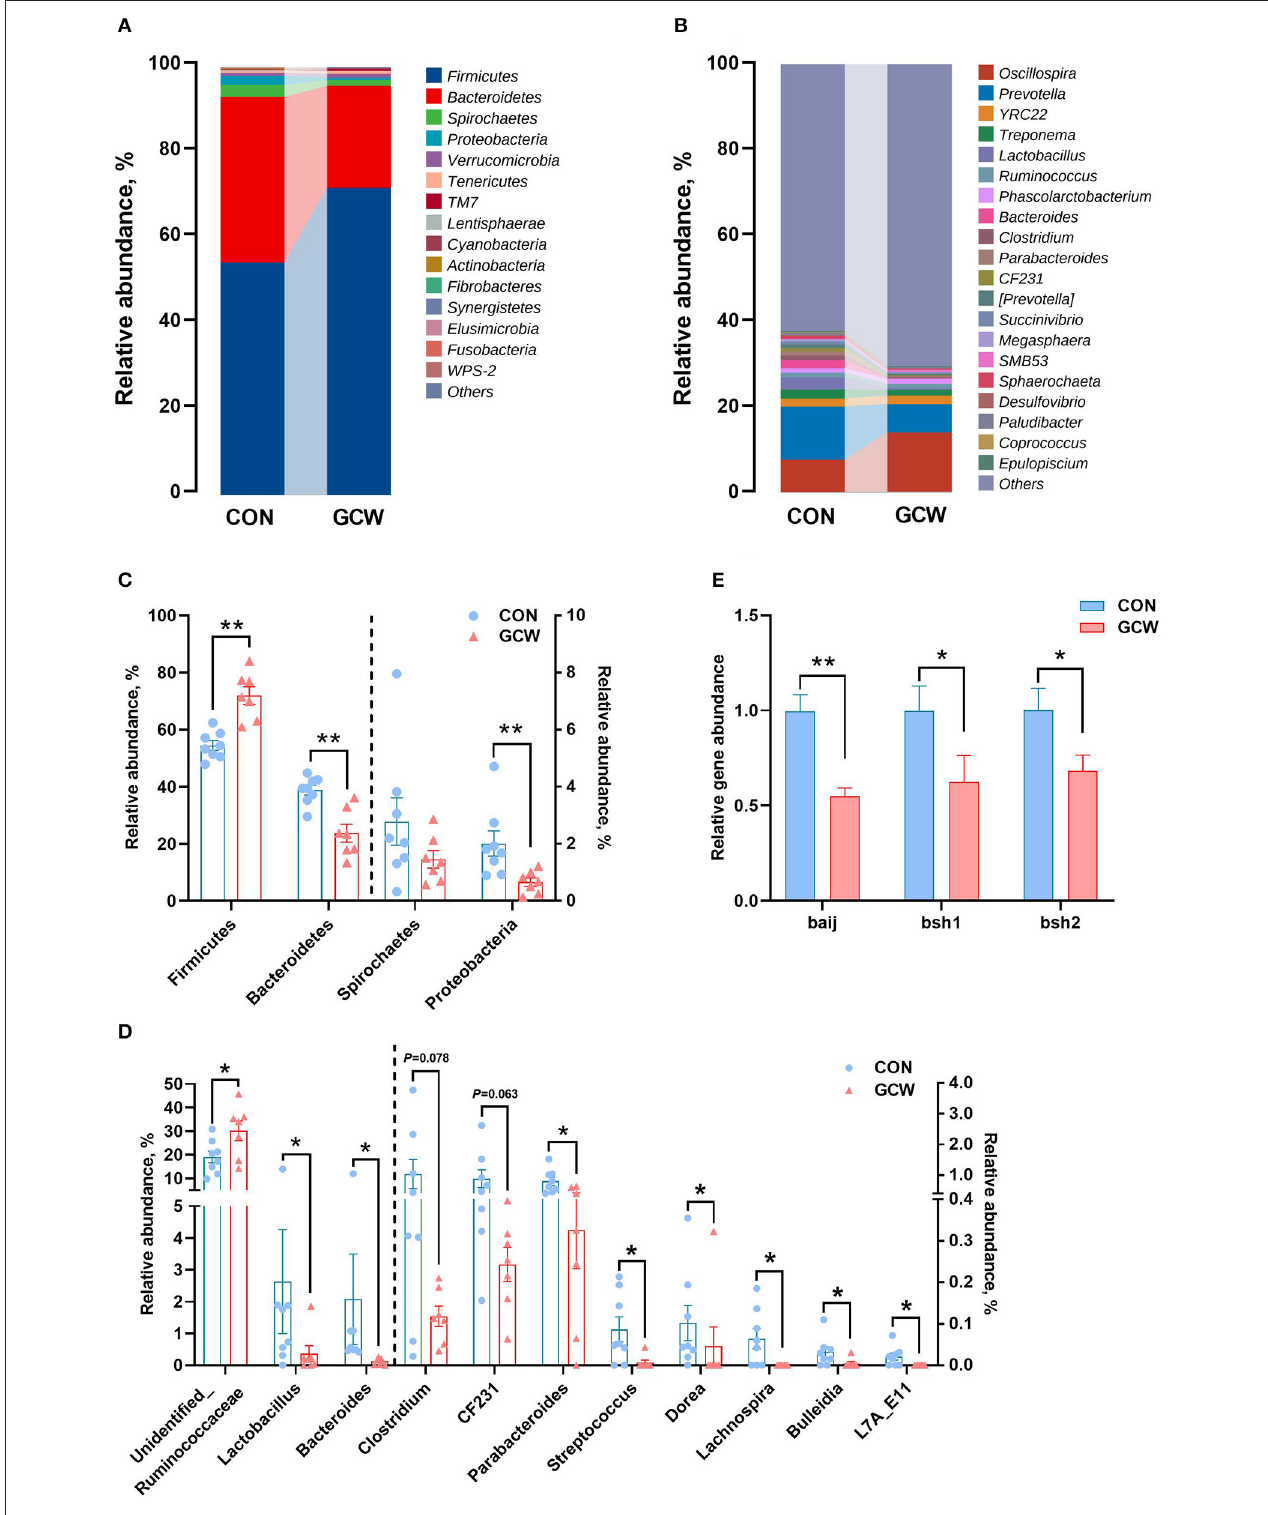
FIGURE 2 | Gut microbiota composition profiles. Bar plot showing relative abundance of microbiota at the phylum (A) and genus (B) levels for the control and GCW groups. Different levels of bacteria at the phylum (C) and genus (D) levels between control ( n = 8) and GCW ( n = 7) groups. (E) Relative abundance of genes involved in bile acid 7 α -dehydroxylation ( baij ) and bile salt hydrolysis ( bsh1 and bsh2 ) between control ( n = 15) and GCW ( n = 14) groups. Data are presented as means ± SEM. * p < 0.05, ** p < 0.01.